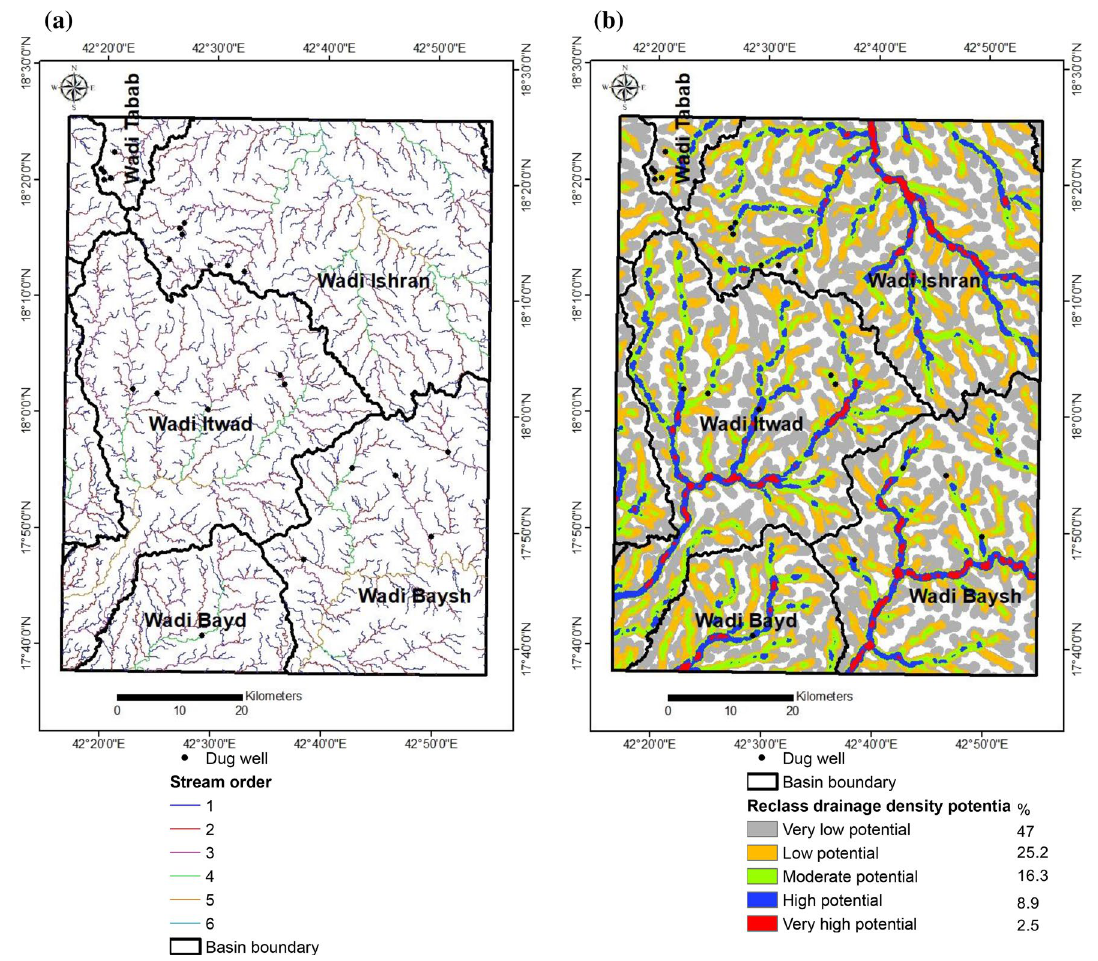
Fig. 7 a Stream network and b reclassified stream network of the study